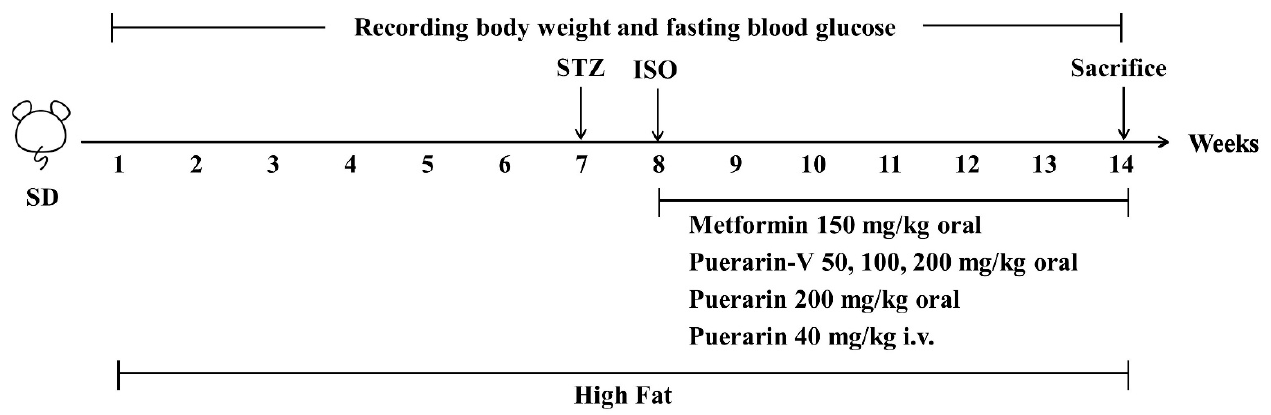
Figure 13. Schematic representation of animal experimental